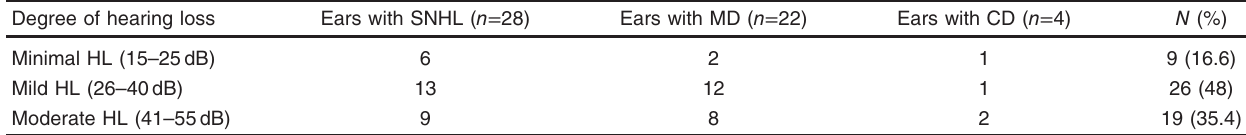
Table 4 Correlation between the type of hearing loss and its degree among the affected ears ( n = 54)